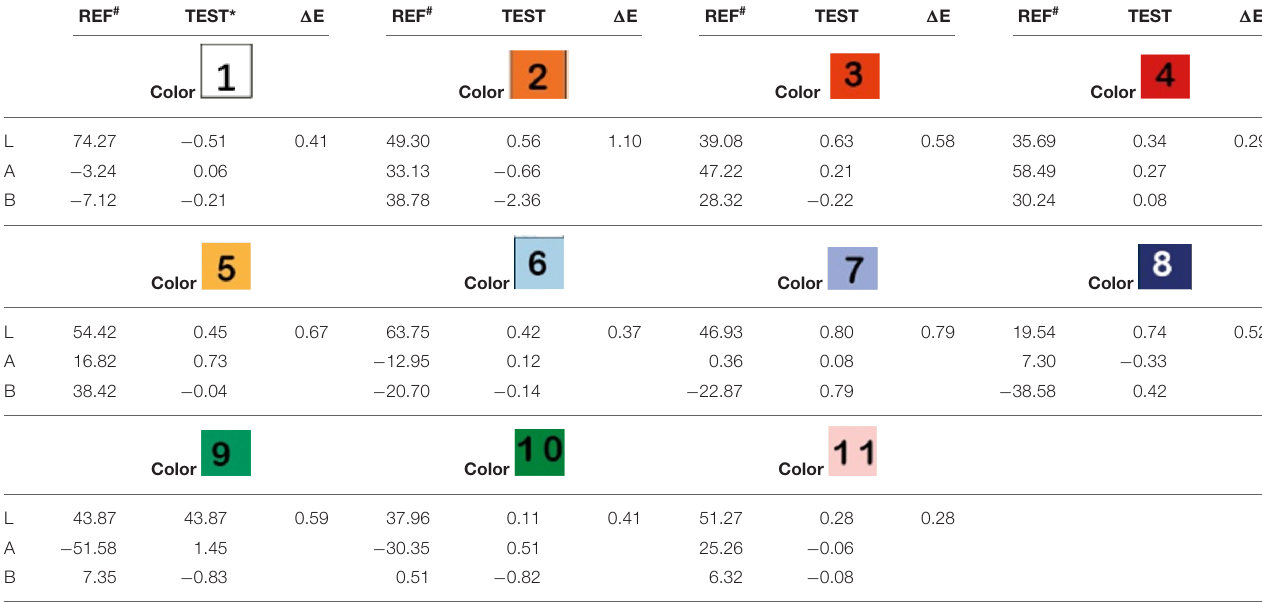
TABLE 1 | Measurement of 11 color spots on the package before and after cooling storage. REF